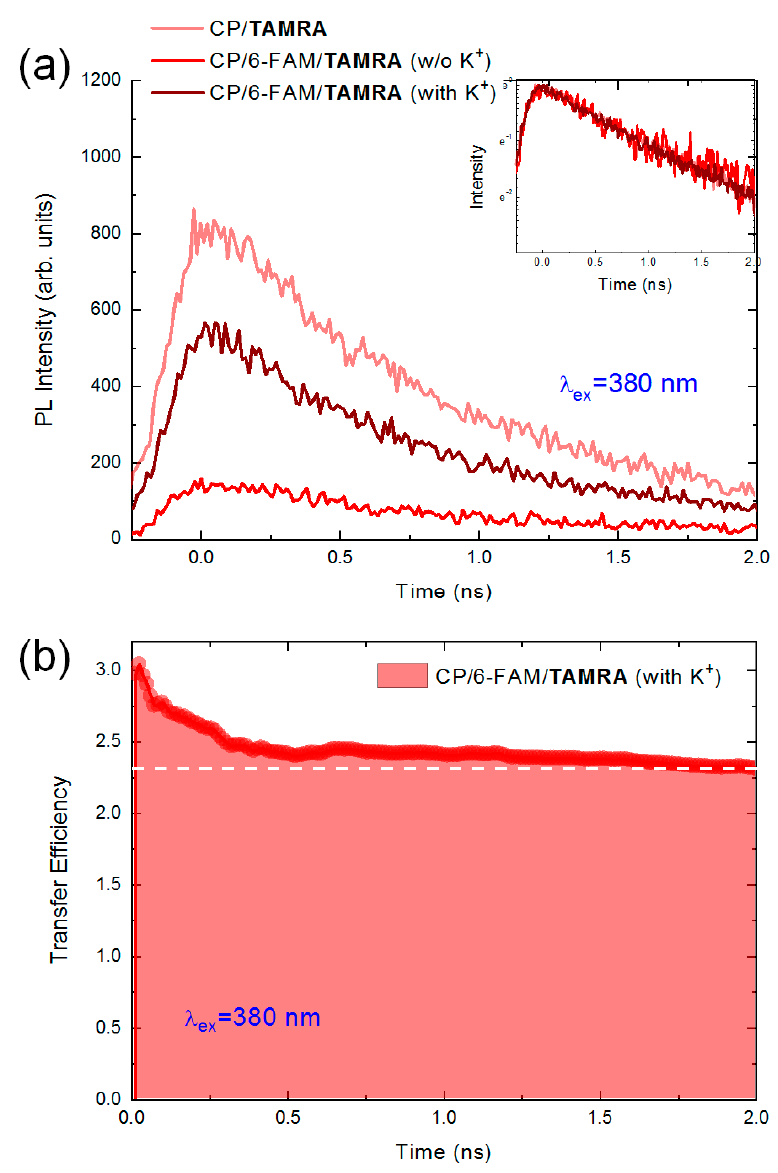
Figure 5. ( a ) To confirm the energy transfer from CPs to TAMRA, the fluorescence decay of TAMRA without 6-FAM was measured ( light red , CP/TAMRA). The fluorescence decay of TAMRA in the absence ( red ) and presence ( wine ) of K + ions; ( b ) The total transfer efficiency TAMRA gained by two-step FRET was calculated using Equation (10).